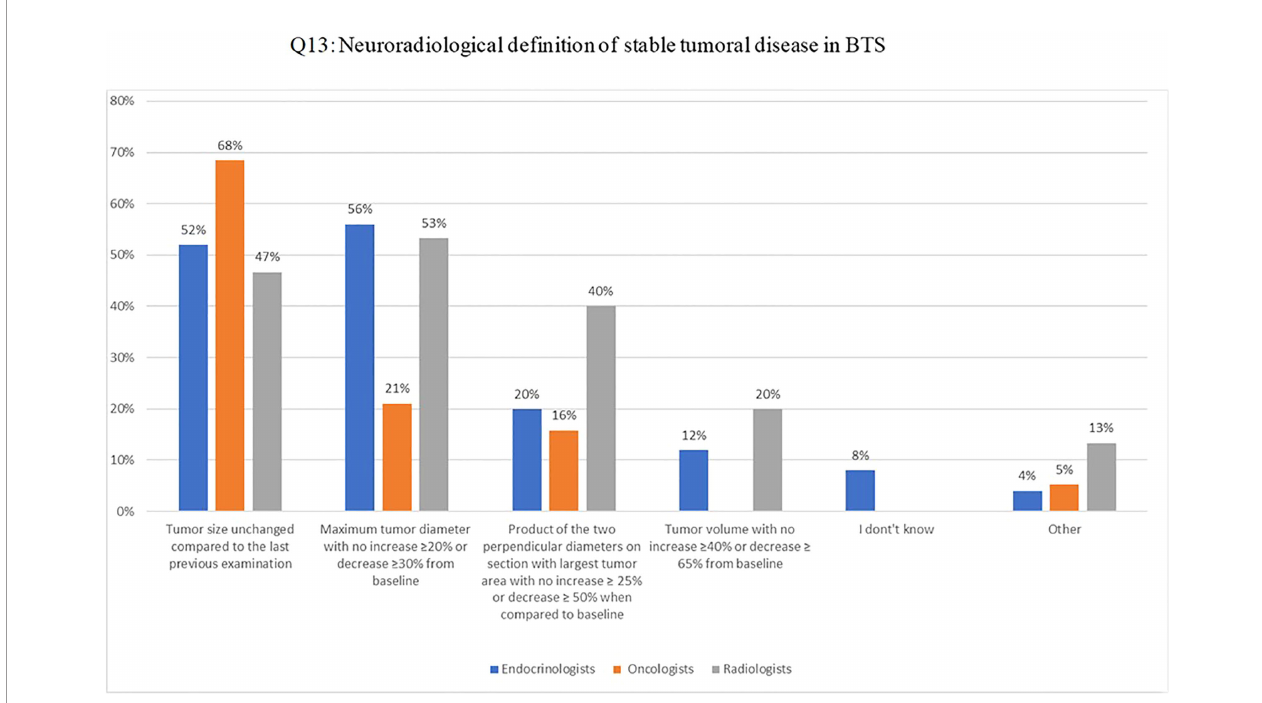
FIGURE 3 | Q13: Neuroradiological de fi nition of stable tumoral disease in BTS.